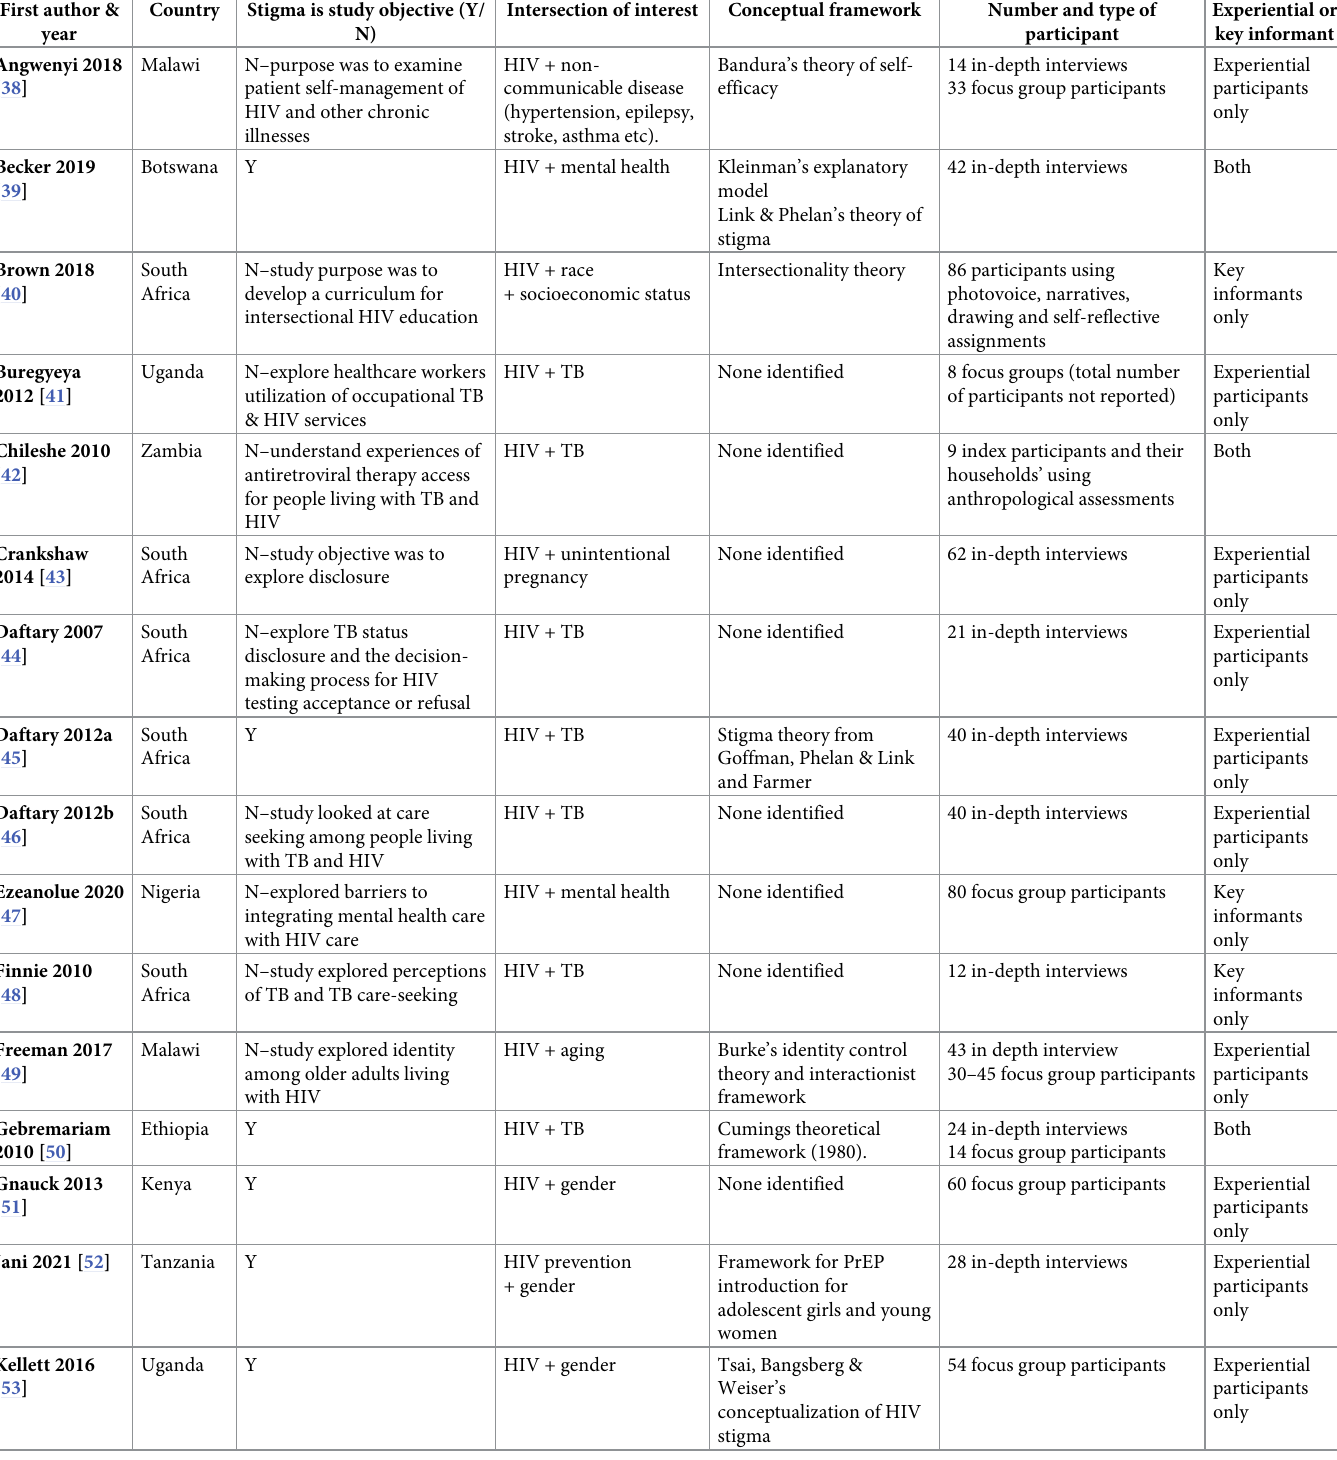
Table 2. Characteristics of included